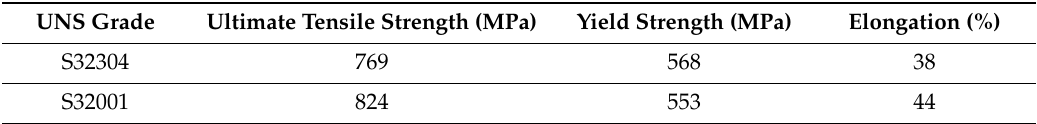
Table 1. Mechanical properties of the duplex stainless-steel bars.